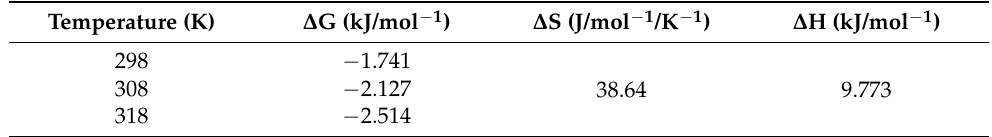
Figure 6. ( a ) Adsorption capacities of DAPFP toward Cr (VI) at different temperature (initial con- centration of Cr (VI): of 1000 mg/L − 1 , pH = 2.0); ( b ) plots of ln Q e /C e against 1/T for the adsorption processes. Table 3. Thermodynamic parameters for the adsorption of Cr(VI) by DAPFP.